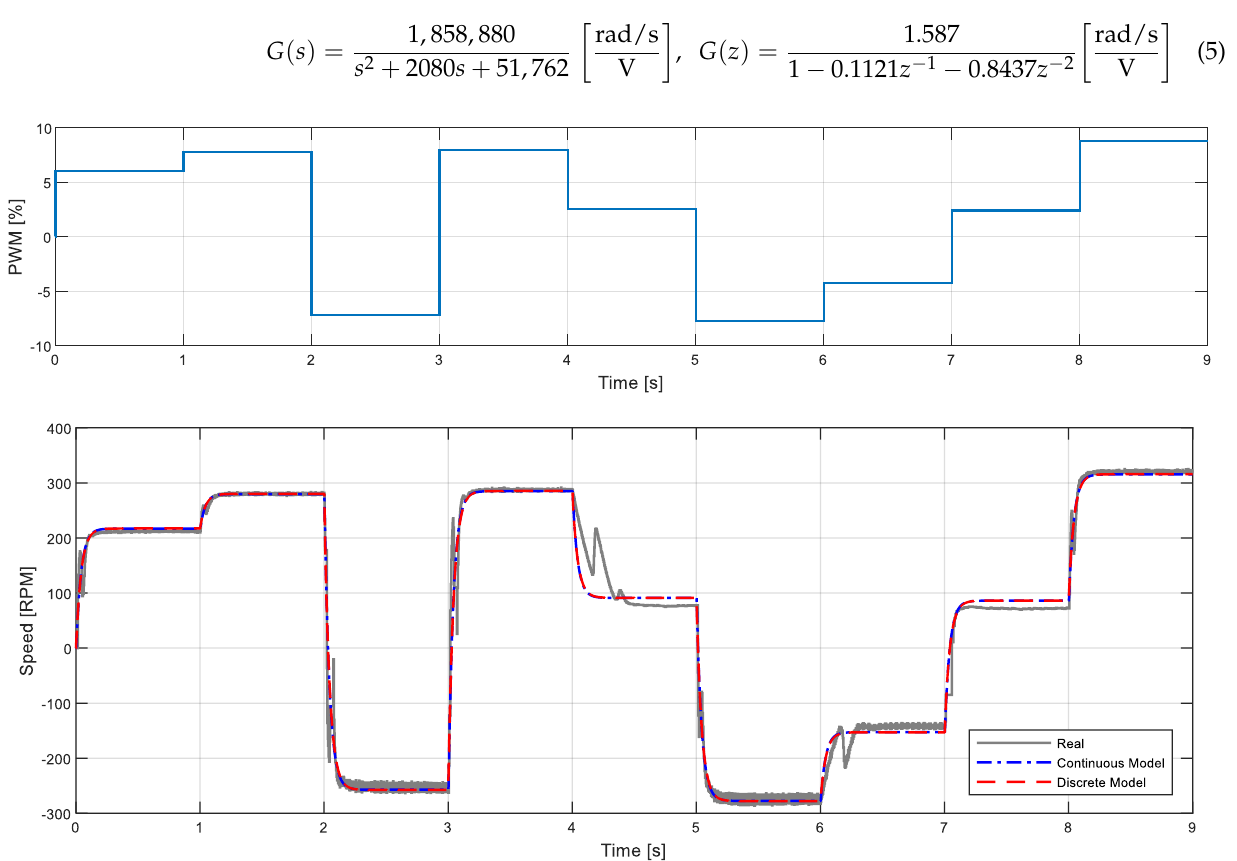
Figure 12. Calibration data required for model calculation: ( a ) PWM duty cycle sequence applied to the motor; ( b ) measured angular rotational velocity of the output shaft (gray line) and generated by the continuous-time (blue dotted line) and discrete-time (red dotted) models found by the SIT Toolbox.